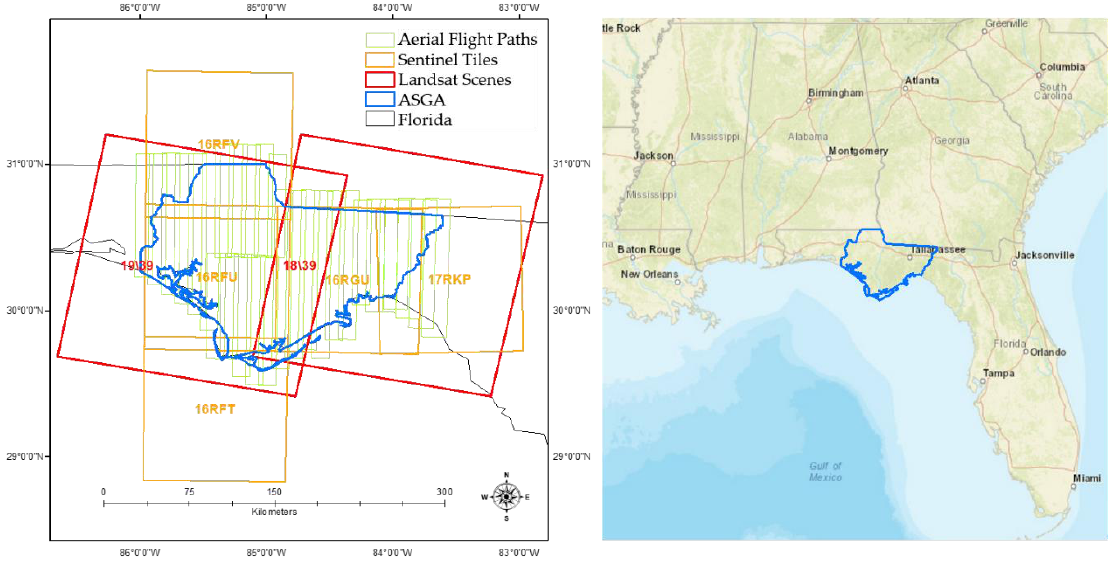
Figure 1. Apalachicola Significant Geographic Area (ASGA) location map ( right ) and image boundaries ( left ). Landsat 8 and Sentinel 2 images were acquired for three seasons, representing a leaf on growing season (LGS), leaf on dormant season (LDS), and a leaf off winter season (LWS). Aerial imagery was only acquired for LDS. Image acquisition dates can be found in Table A2.